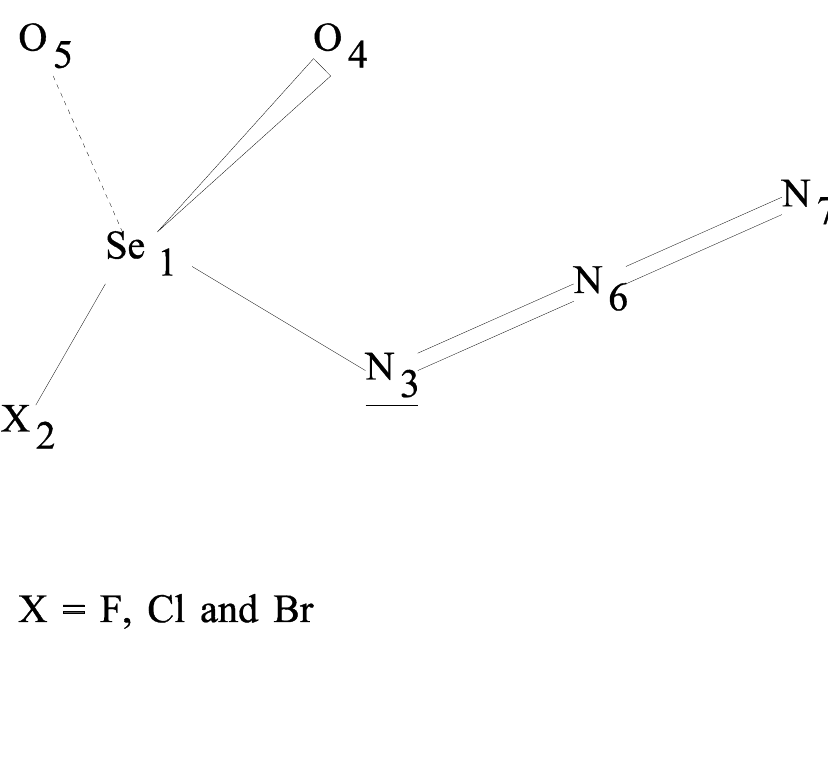
Figure 1 : Atom numbering for haloselenonyl azides (X is F, Cl and